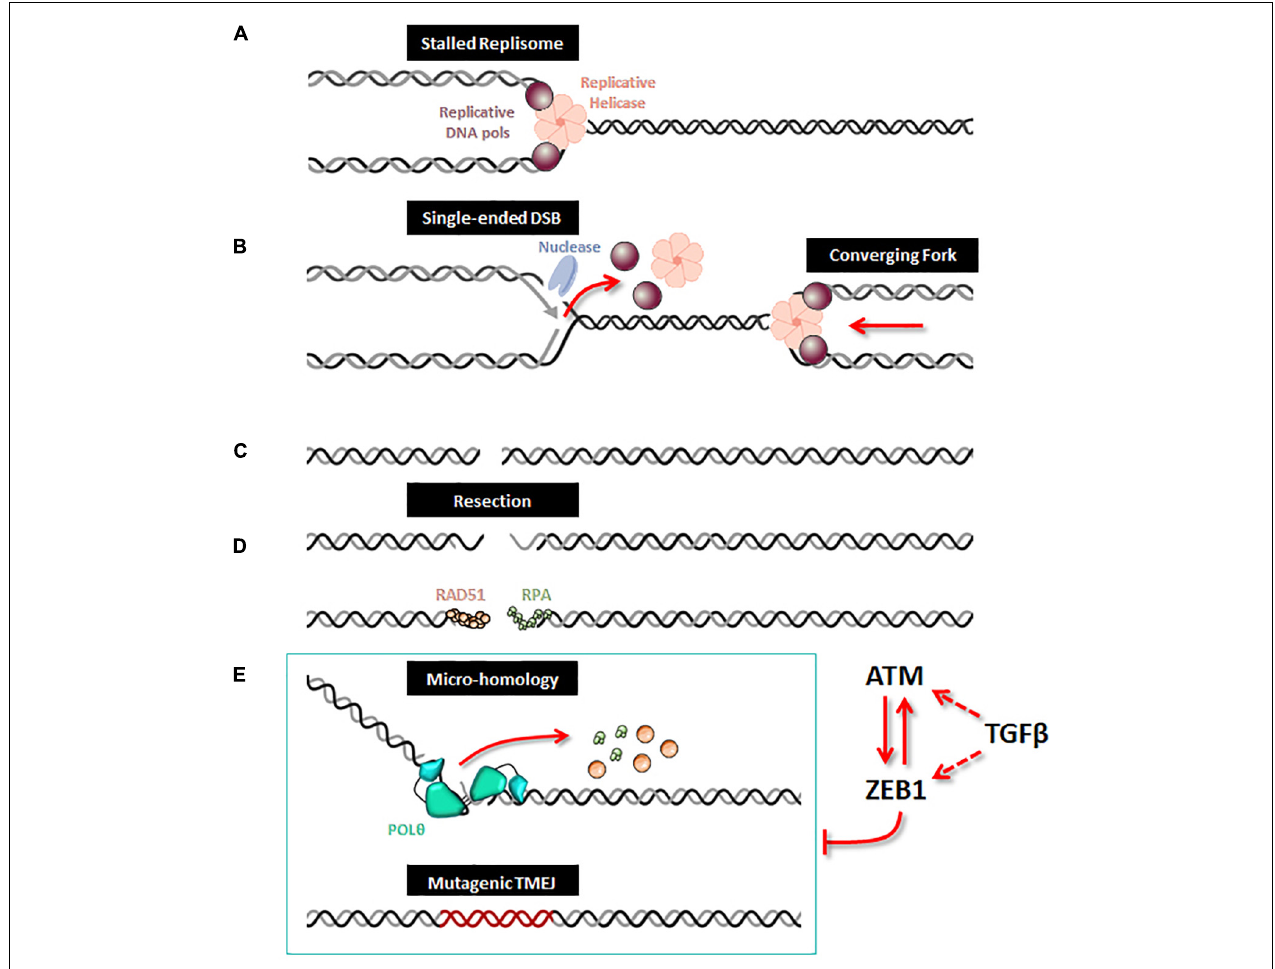
FIGURE 1 | ZEB1/EMT controls TMEJ. When a replication fork is stalled (A) , unloading of the replicative helicase and DNA polymerases leads to incision by a DNA nuclease, which creates a single-ended DSB (B) . After replication forks completion, a DSB is generated (C) . A 5 (cid:48) to 3 (cid:48) end resection generates single-stranded DNA, along which RPA and Rad51 loading can occur (D) . When homologous recombination is defective, the alternative TMEJ pathway can operate on this resected DSB (E) ; POL θ is recruited as a dimer which facilitates the proximity of DNA ends and stabilizes synapsed intermediates; the helicase domain of POL θ can displace either RPA or RAD51 and the polymerase domain executes a bidirectional scanning initiated from the 3 (cid:48) termini to identify internal microhomologies which can be annealed, thus generating 3 (cid:48) flaps. POL θ then removes the 3 (cid:48) flaps and starts DNA synthesis with poor processivity and frequent aborted synthesis resulting in a high rate of mutations including deletions and insertions from template switching events. When ZEB1 is expressed and stabilized by ATM, the expression of POLQ (encoding the POL θ protein) is decreased and therefore impedes the action of the alternative mutagenic TMEJ pathway on the resected DSB. The TMEJ inhibition by ZEB1 combined with ATM activity enhances accurate homologous recombination. Moreover, ZEB1 activates the transcription of ATM, both being under direct or indirect control of TGF β